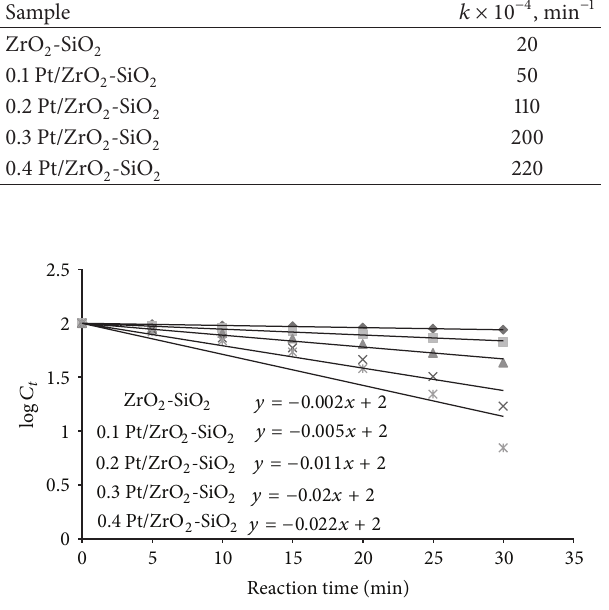
Figure 6: The effect of wt% of Pt on the rate constant of CN − with ZrO 2 -SiO 2 and various combinations of Pt/ZrO 2 -SiO 2 .